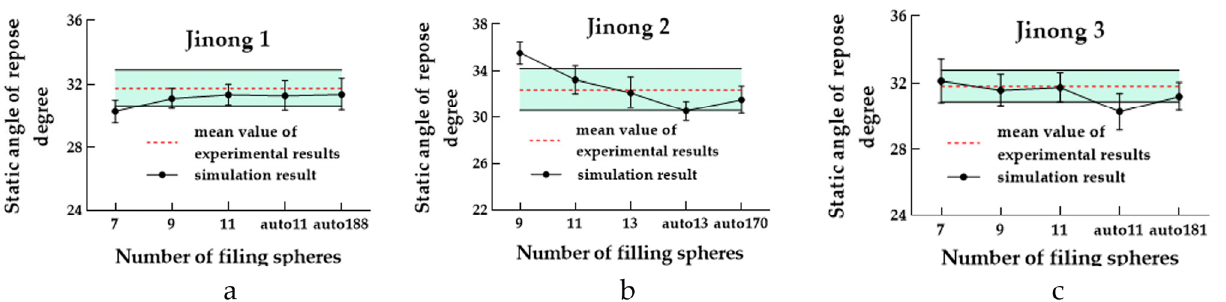
Figure 15. Snapshots of the simulation of the piling test of Jinong 2 seeds using the 170-sphere model.